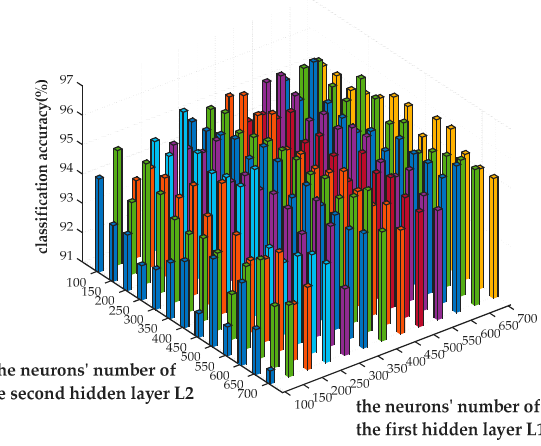
Figure 7. The effect of changed neuron’s numbers on classification accuracy.